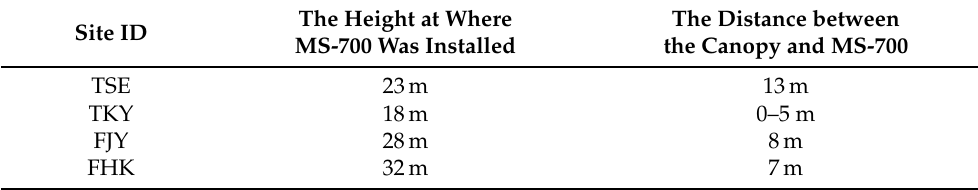
Figure 3. Examples of the instruments: MS-700, masking device, and Automatic-capturing Digital Fisheye Camera (ADFC) at ( a ) FHK and ( b ) TKY. At TSE and FJY, the instruments were installed basically in the same manner as ( a ) FHK, but FJY was not equipped with the masking device for MS-700. At TKY, an external motor rotates MS-700 to observe the incident and reflected light ( b ). Table 2. The vertical positional information of the canopy and downward MS-700 at each